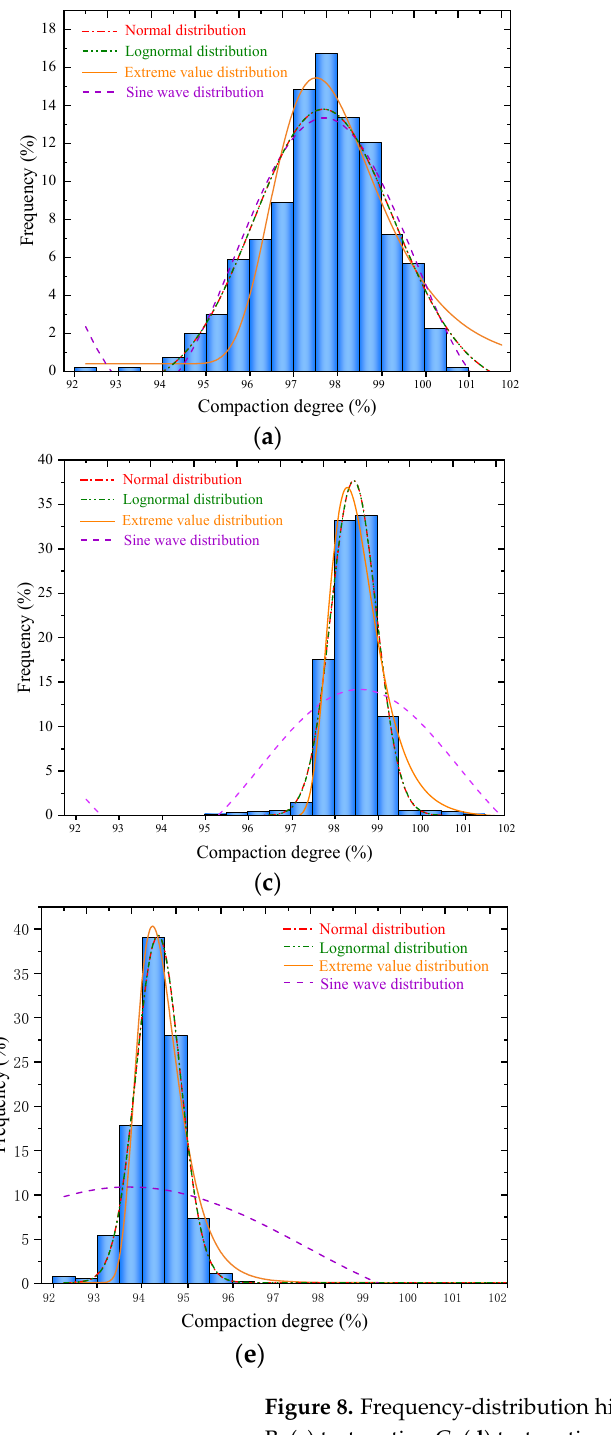
distribution histogram of the compaction degree was fitted by the probability distribu ‐